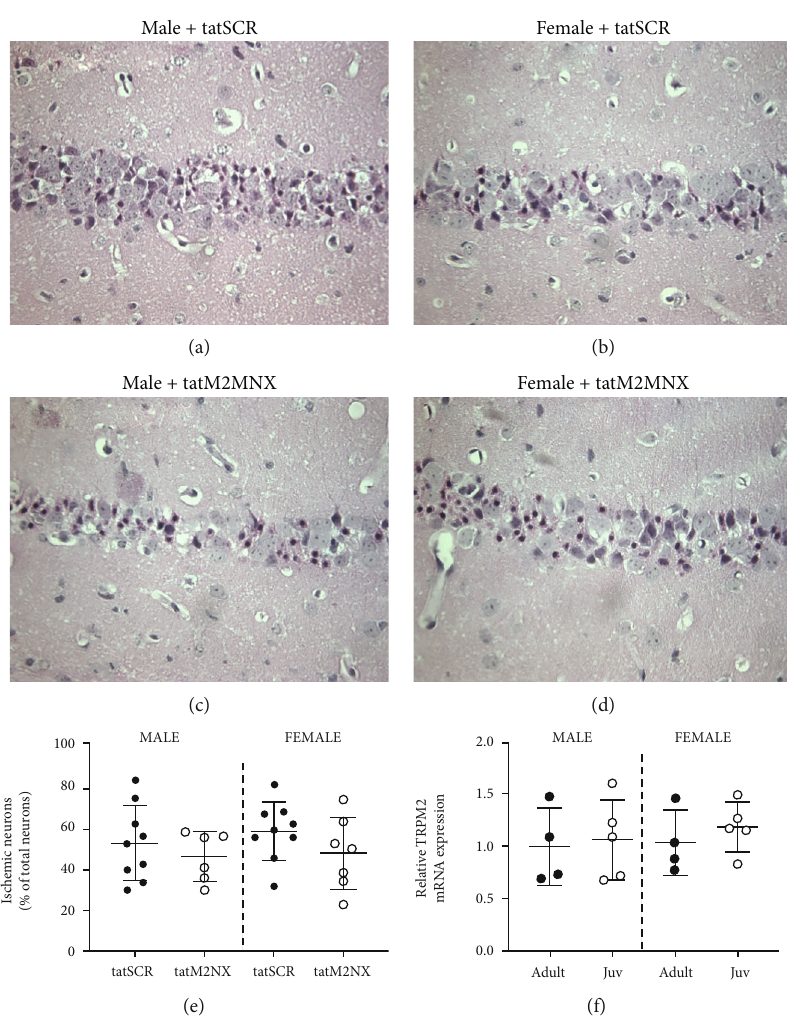
Figure 1: TRPM2 inhibition does not reduce neuronal death following juvenile CA/CPR. Representative photomicrographs of hippocampal CA1 neurons after CA/CPR. Ischemic CA1 neurons were identi fi ed by hypereosinophilic cytoplasm and pyknotic nuclei and were presented as a percent of total CA1 neurons. Males were administered 20 mg/kg tatSCR (a) or tatM2NX (b), and females were administered 20mg/kg tatSCR (c) or tatM2NX (d) 30 minutes after CA/CPR. (e) Quanti fi cation of ischemic CA1 neurons 3 days after CA/CPR. (f) Quantitative RT-PCR of TRPM2 mRNA expression in the hippocampus of adult (3-4-month-old) and juvenile (21-25-day-old) mice in both